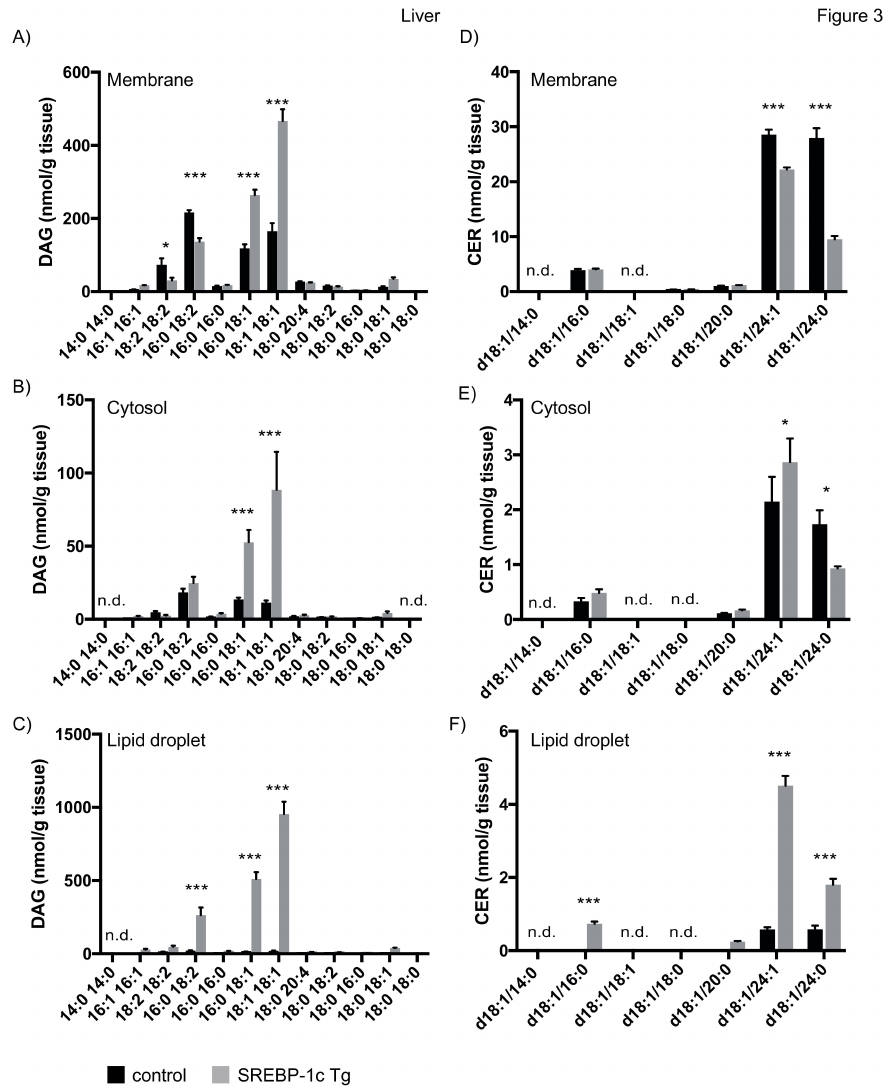
Figure 3. Mass spectrometry analysis of DAGs and CERs in liver tissue fractions. Liver tissue of SREBP-1c adipose-specific overexpressing transgenic (Tg) mice (SREBP-1c Tg) and control mice was subjected to subcellular fractionation. The indicated DAG species were analysed by LC-MS/MS in membrane ( A ), cytosolic ( B ) and LD fraction ( C ). The indicated CER species were analysed in membrane ( D ), cytosolic ( E ) and LD fraction ( F ). All data are presented as mean ± SEM (n = 6 per group). n.d., not detected; * p < 0.05, *** p < 0.001; 2-way ANOVA with Bonferroni